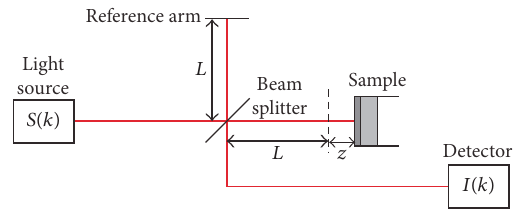
Figure 1: Schematic representation of the Fourier-domain OCT system. The length of the reference and sample arm is indicated with 𝐿 and the unidirectional distance from the zero-delay point with 𝑧